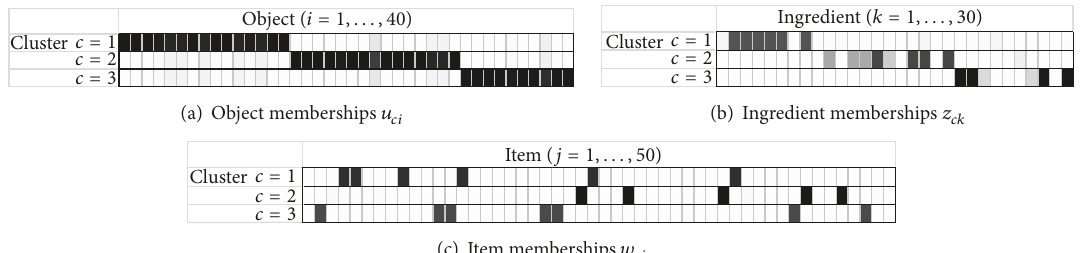
Figure 2: Derived memberships by proposed